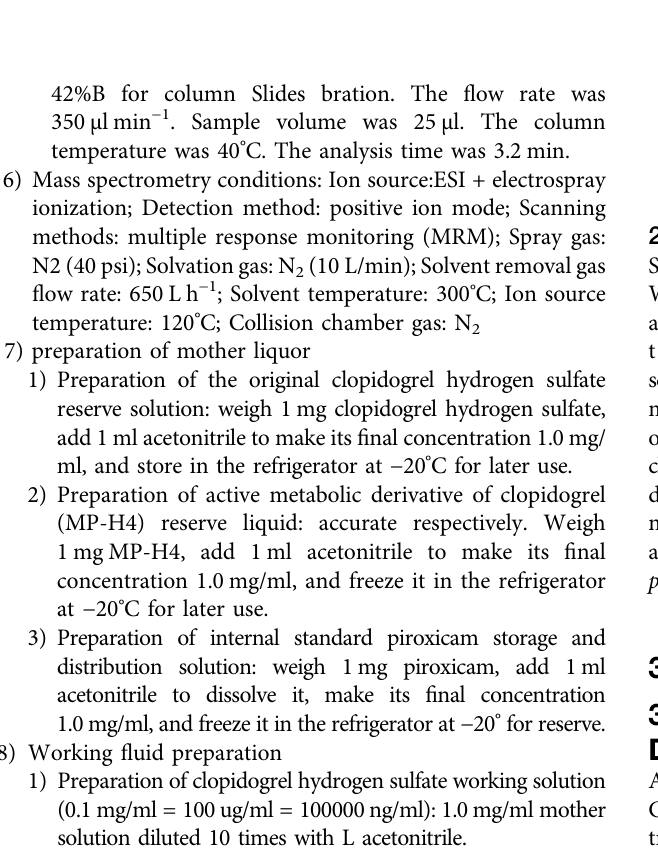
Frontiers in Pharmacology |